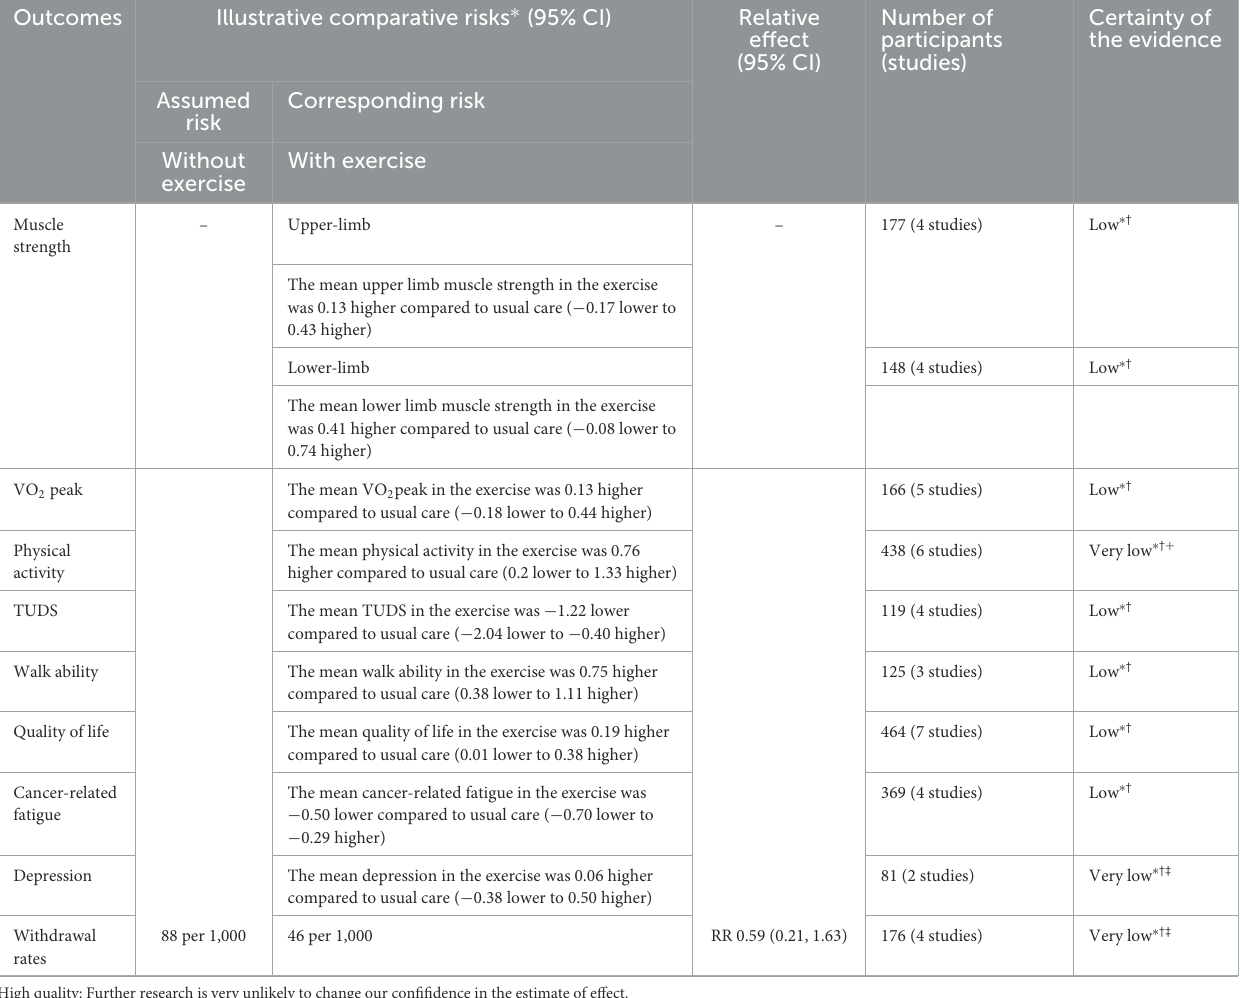
TABLE 2 The GRADE tool for the pooled results in the patients after concurrent